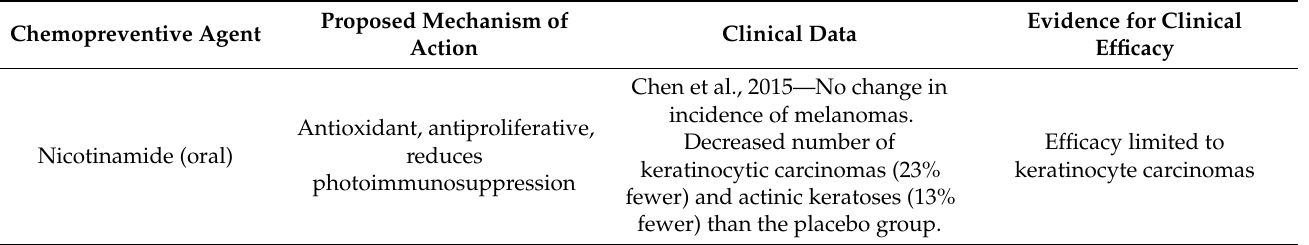
Table 2. A summary of the clinical evidence for chemopreventive agents. Chemopreventive